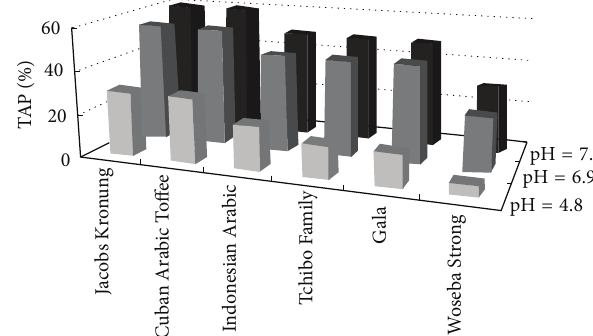
Figure 2: TAP values of various coffees at different